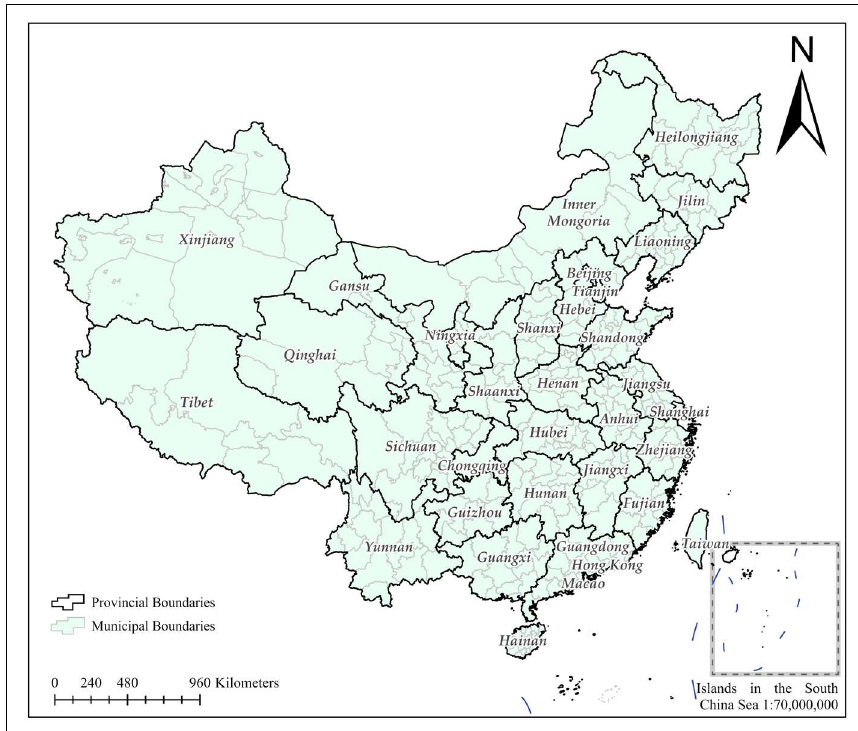
Figure 1. Study area. Administrative divisions of provinces and cities in China .